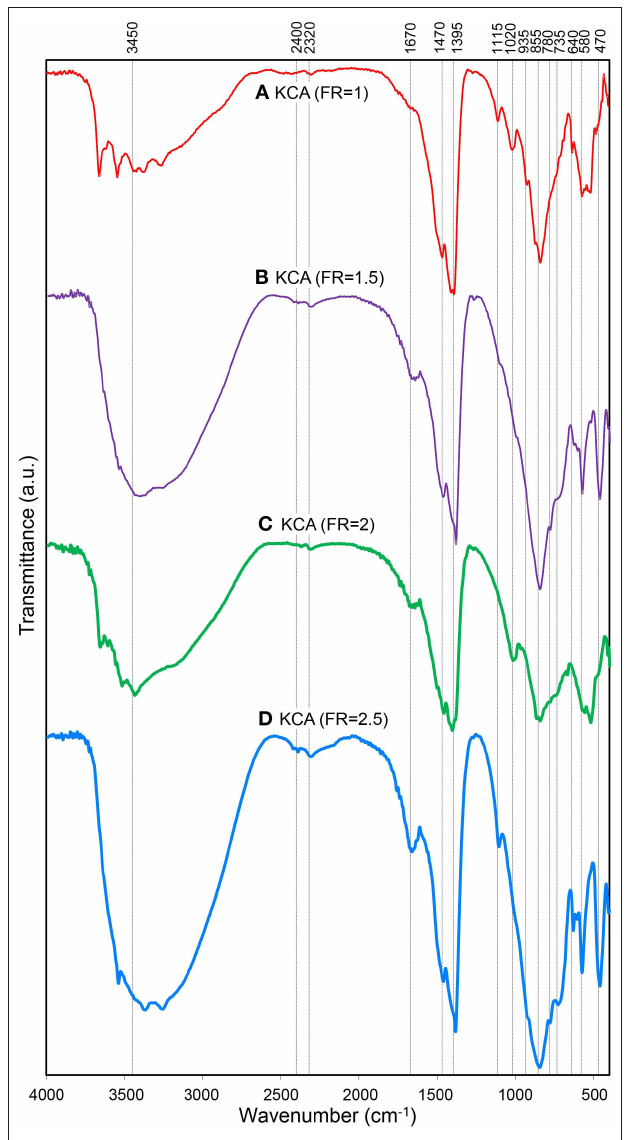
FIGURE 4 | FTIR spectra of synthesized KOH/Ca 12 Al 14 O 33 nanostructured catalysts with various fuel ratios: (A) KCA(FR = 1), (B) KCA(FR = 1.5), (C) KCA(FR = 2), and (D) KCA(FR =